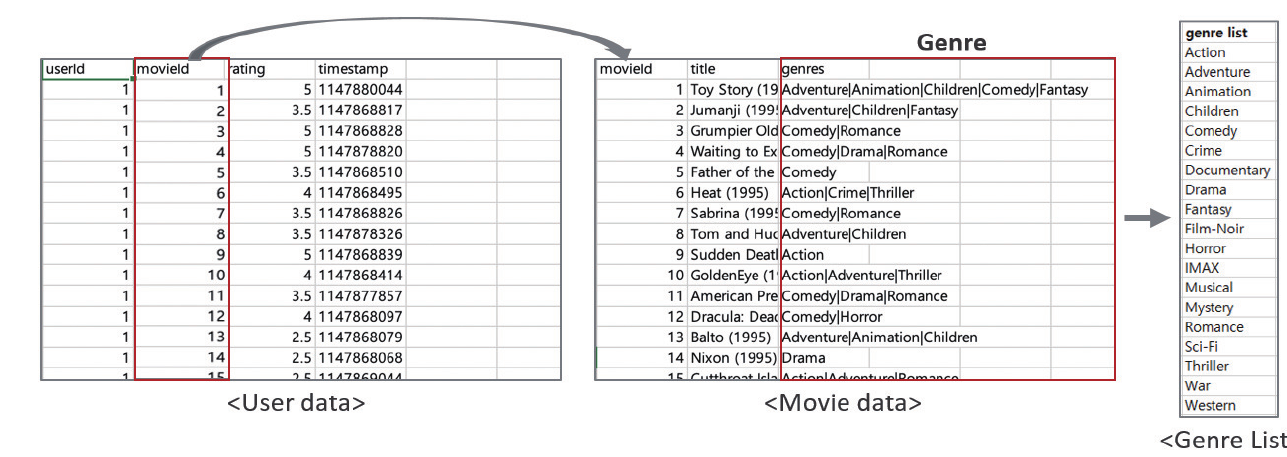
Figure 3. Example of data preprocessing for movie genre prediction ( n =